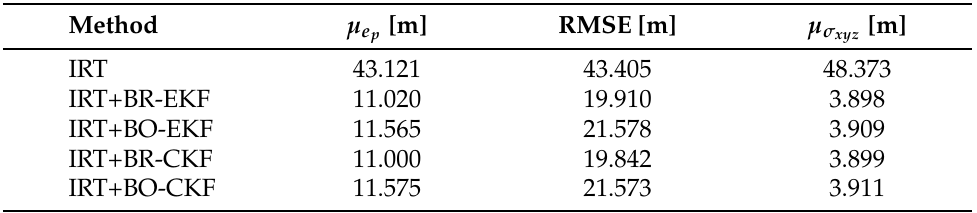
Table 6. IRT, IRT+BR-EKF, IRT+BO-EKF, IRT+BR-CKF and IRT+BO-CKF results for the flat terrain scenario.